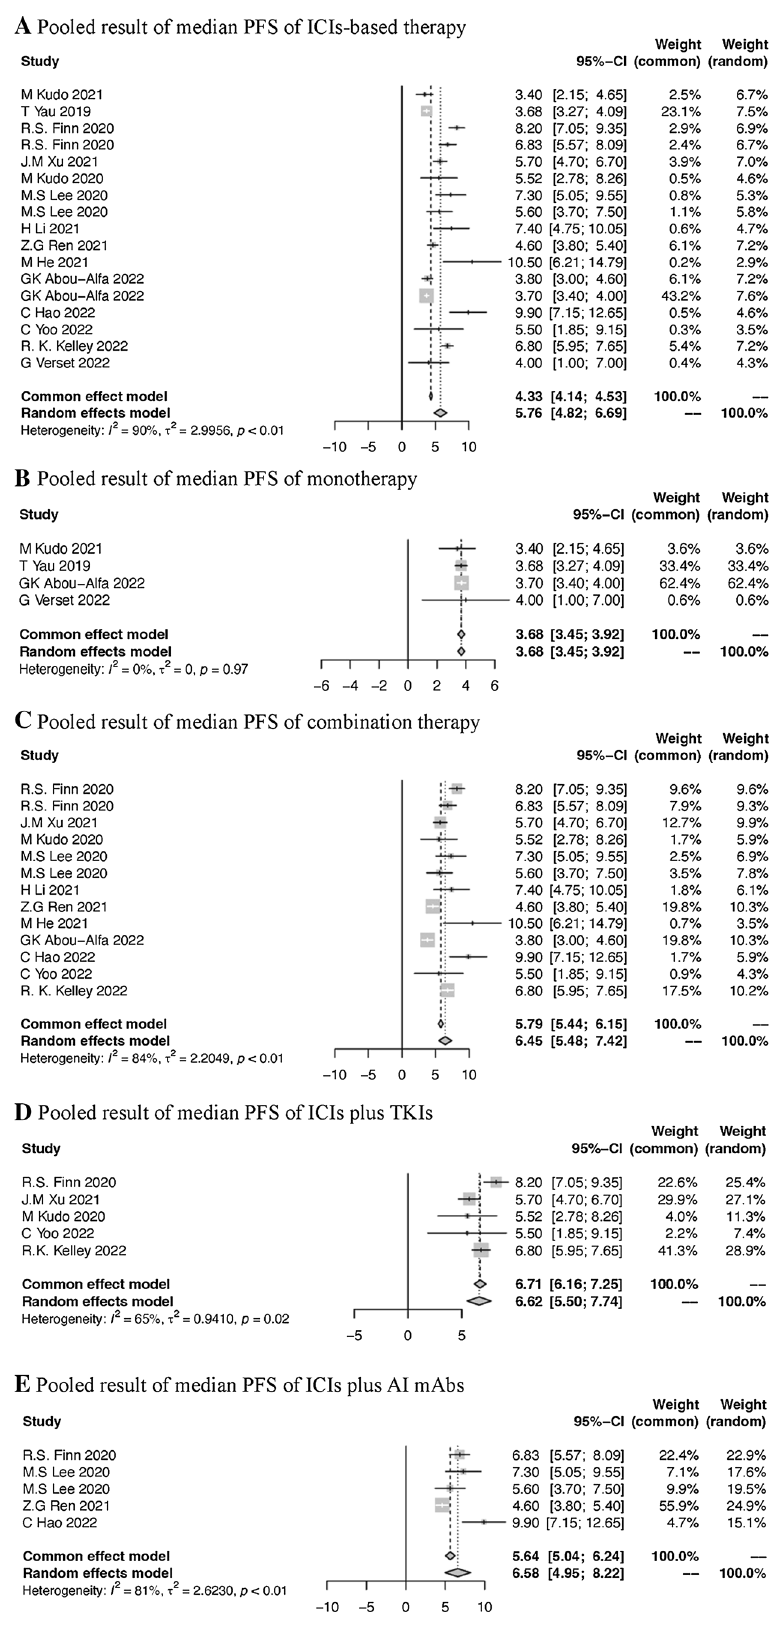
Fig. 3 Pooled results of